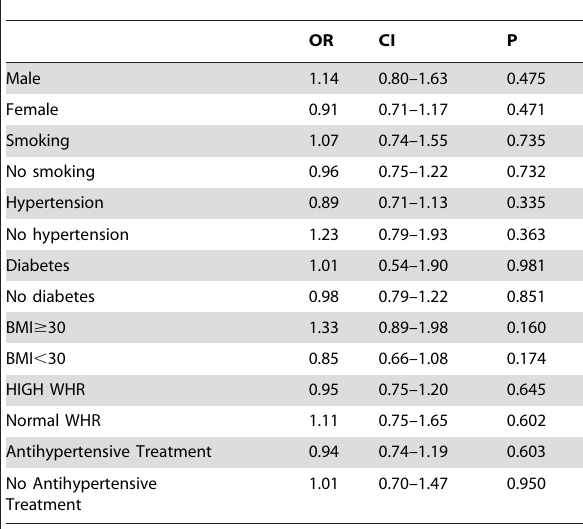
Table 7. Multivariate analysis of variables with PVLMILVH as the outcome variable and log of Insulin Resistance as the explanatory